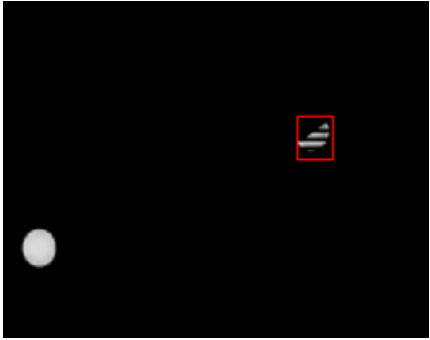
Figure 18. The tracking performance when half of the LED is shielded.